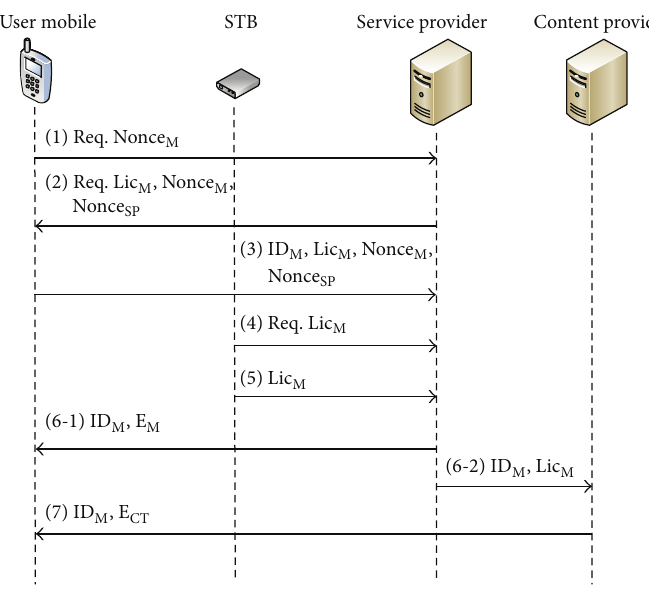
Figure 6: Third phase process of migrating mobile devices to STB through base